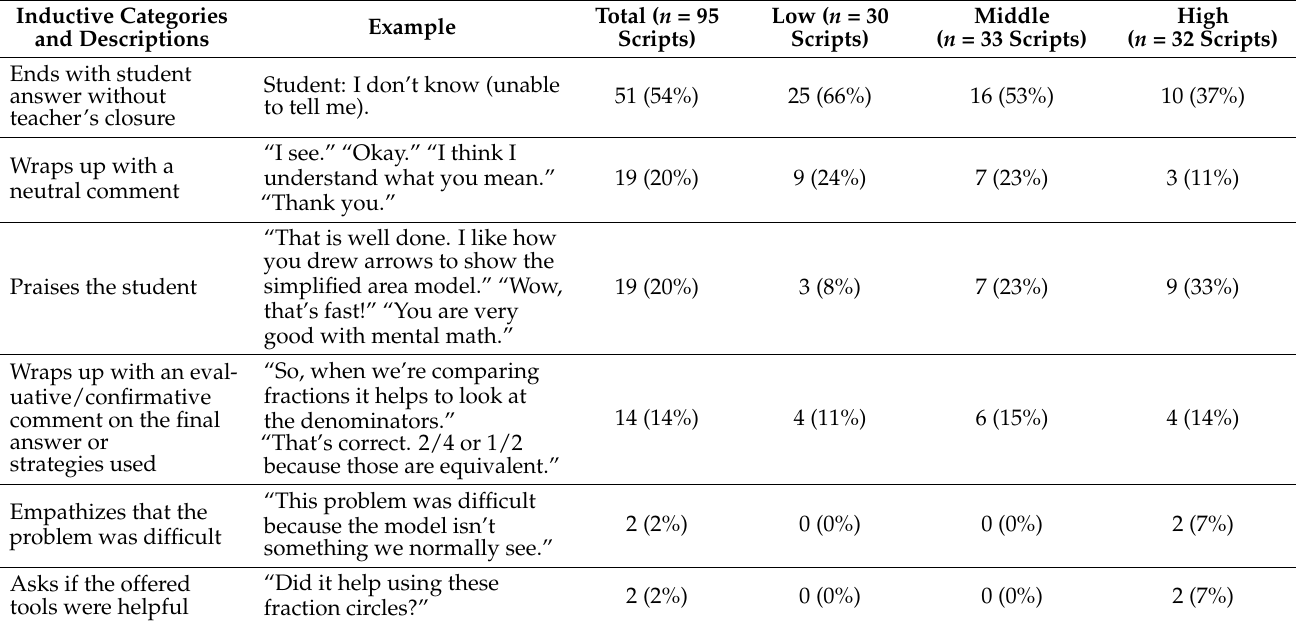
Table 6. Analysis of teacher talks during